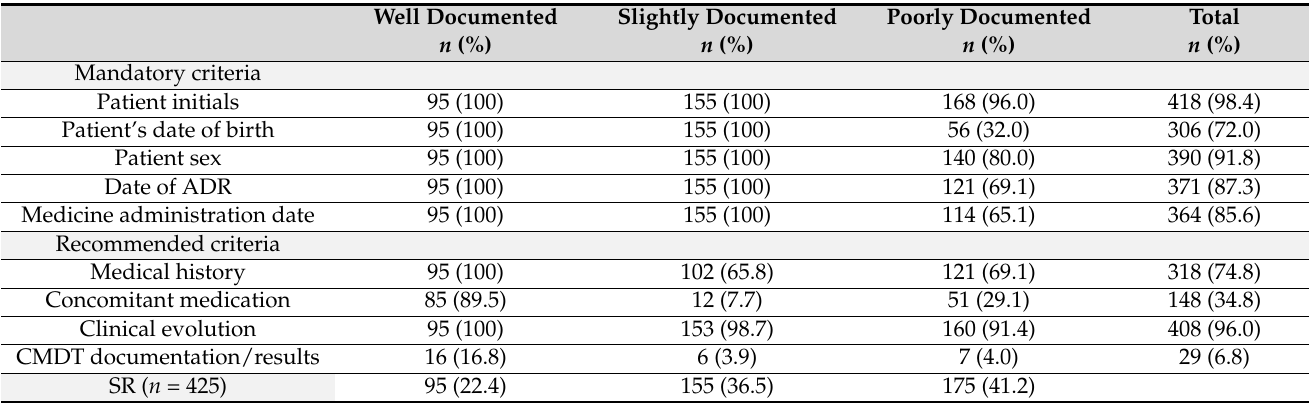
Table 1. Proportions of the nine mandatory and recommended criteria of spontaneous reports sent to the Pharmacovigilance Unit of Beira Interior between 1 January 2017 and 31 October 2019, distributed in three categories (“well documented”, “slightly documented”, “poorly